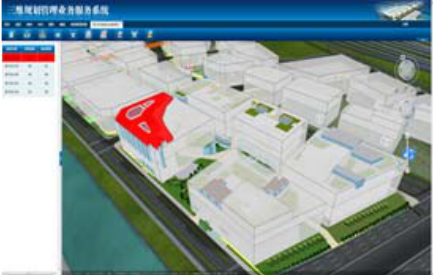
Figure 2. The assisted approval system of three-dimensional construction